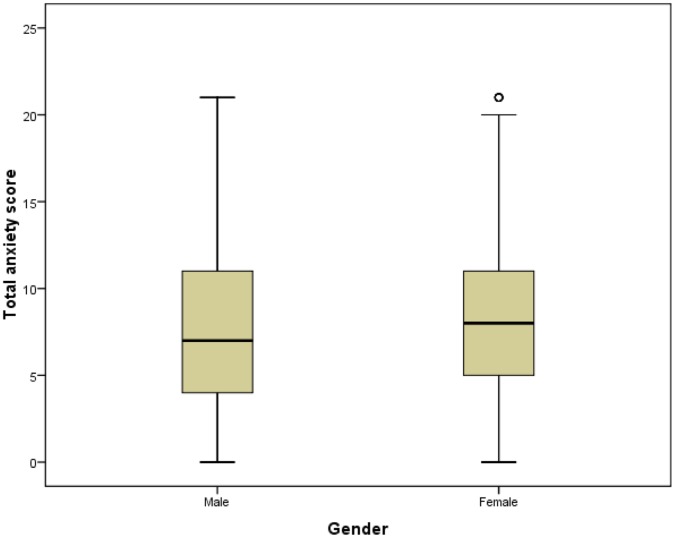
Anxiety scores for men and women.The anxiety scores for men and women are indicated. It can be seen that the women’s scores are higher than men’s.